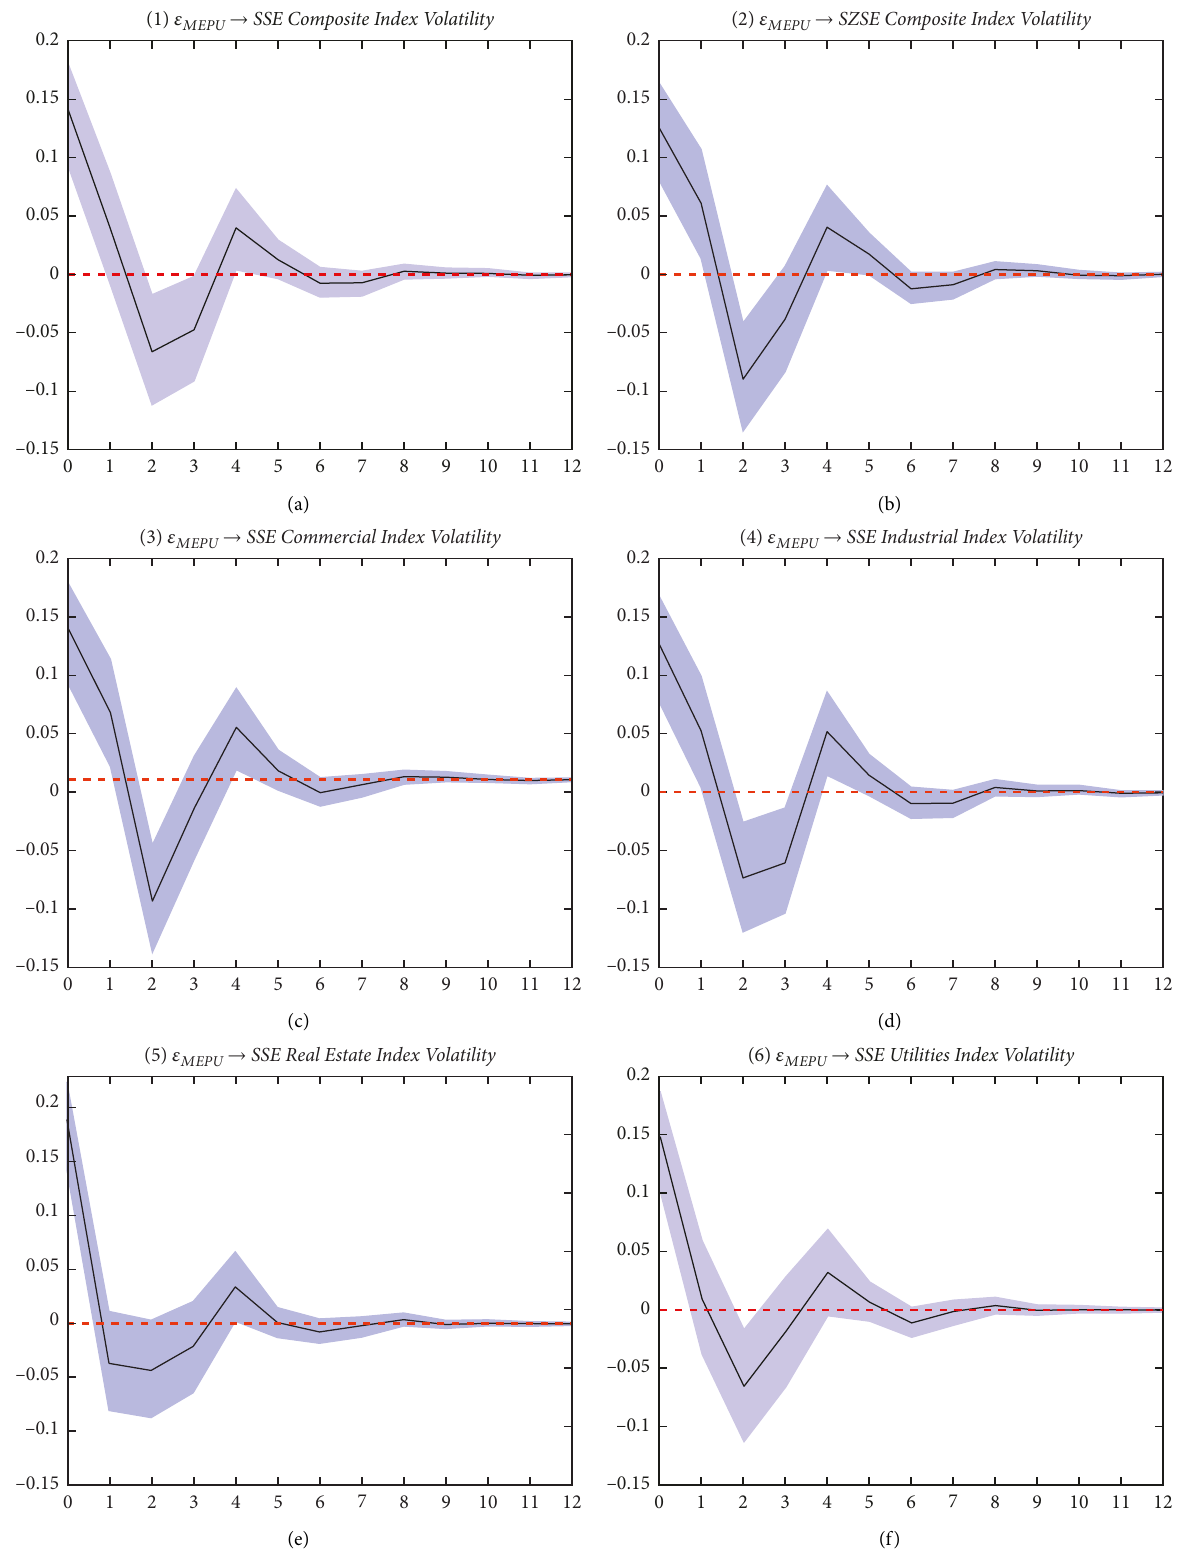
Figure 11: Cumulative impulse response of stock market volatility to monetary EPU (MEPU) shocks Notes: the solid black lines denote the median impulse response. The light-colored region represents 68% of error bands. Each period is a